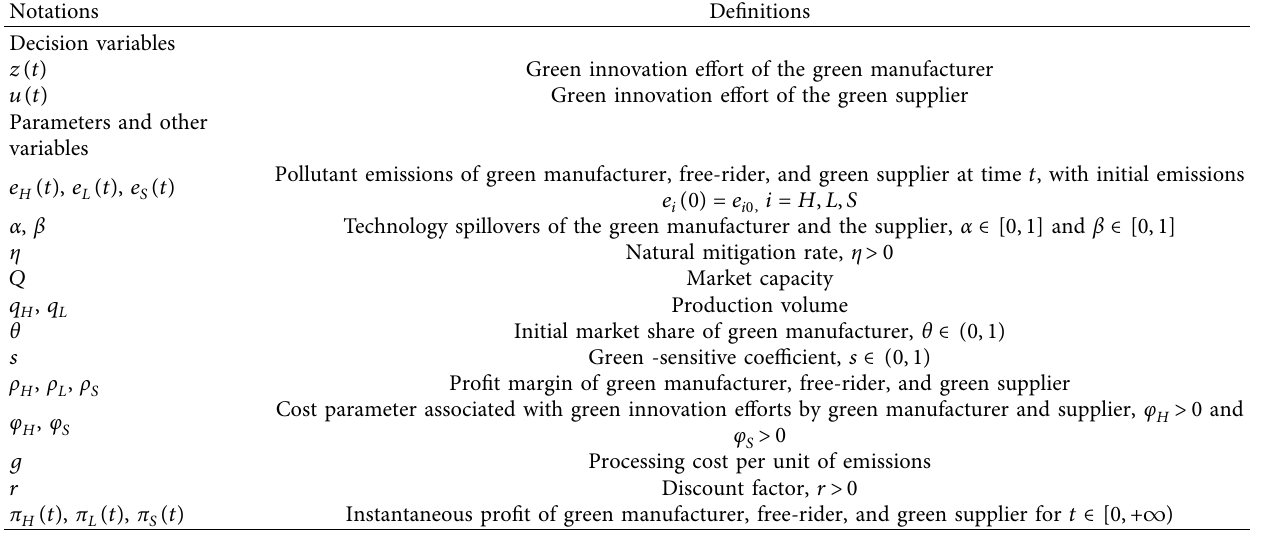
Table 1: Notations and